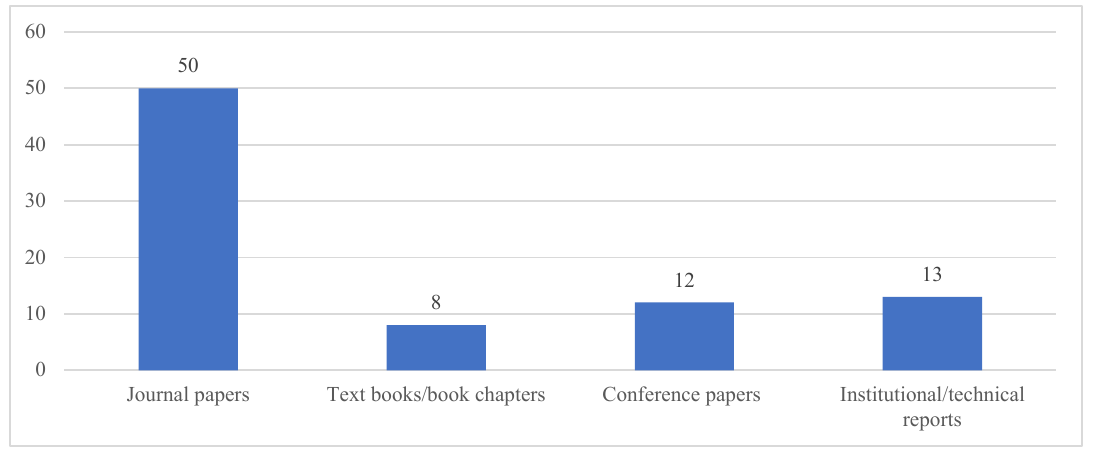
Fig. 1. Classification of literature